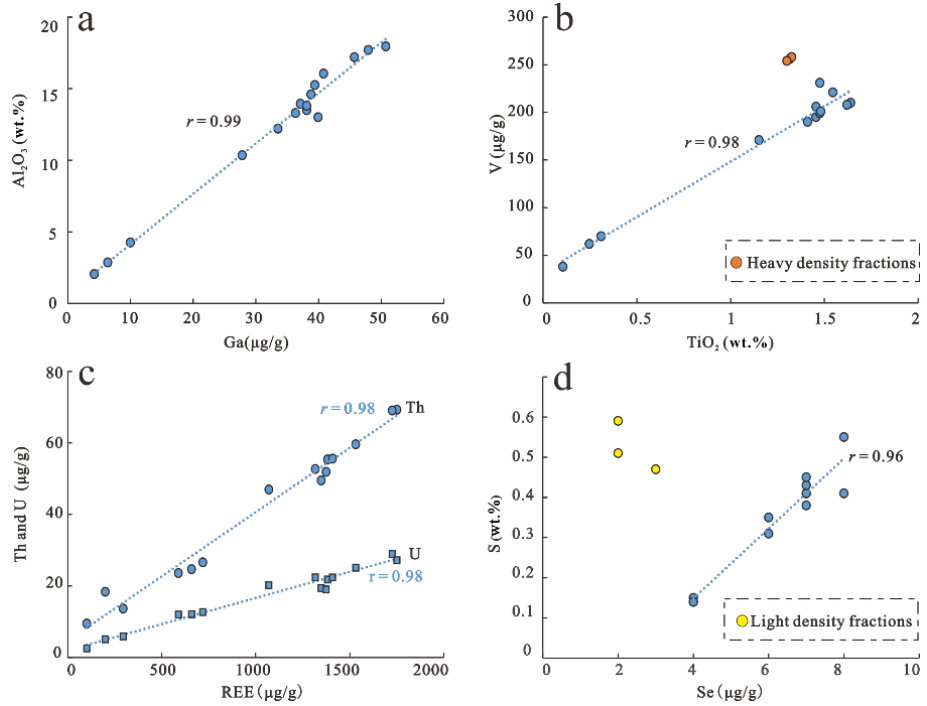
Figure 10. Bivariate plots of Ga vs. Al 2 O 3 ( a ), TiO 2 vs. V ( b ), REE vs. Th and U ( c ), and Se vs. S ( d ).